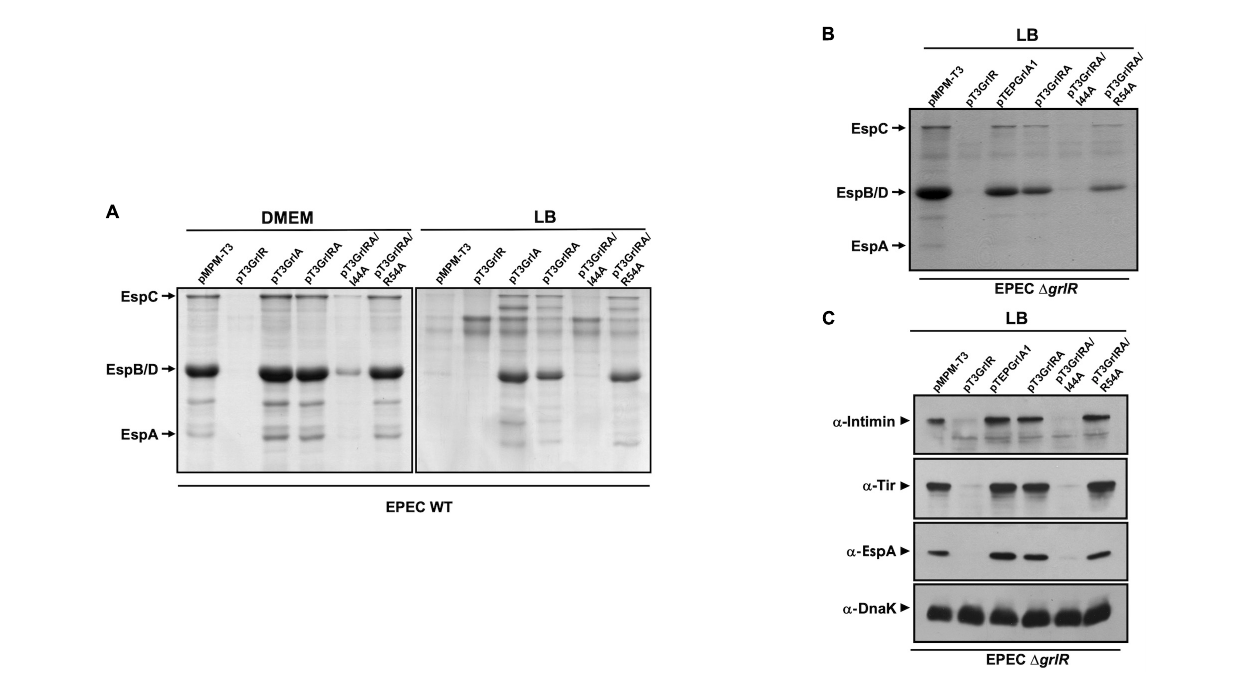
FIGURE6 GrlA antagonizes GrlR-mediated repression. (A) Profile of secreted proteins from WT enteropathogenic Escherichia coli (EPEC) carrying the empty vector pMPM-T3 or its derivatives pT3GrlR, pTEPGrlA1, and pT3GrlRA, pT3GrlRA/I44A and pT3GrlRA/R54A grown in 50 ml Dulbecco’s modified Eagle’s medium (DMEM) or Lysogeny Broth (LB) to an OD 600 of 1. Secreted proteins were concentrated from culture supernatants by precipitation with trichloroacetic acid (TCA), separated by 12% SDS-PAGE and stained with Coomassie brilliant blue. (B) Secreted proteins from EPEC (cid:49) grlR carrying the same plasmids as in panel (A) grown in 50 ml of LB with shaking at 37 ◦ C. (C) Total extracts were prepared from bacterial samples of the same cultures described in panel (B) . Proteins were separated by 12% SDS-PAGE and expression of intimin, Tir and EspA was analyzed by western blotting using anti-intimin, anti-Tir and anti-EspA antibodies. As a control for protein loading, DnaK expression was also analyzed using anti-DnaK